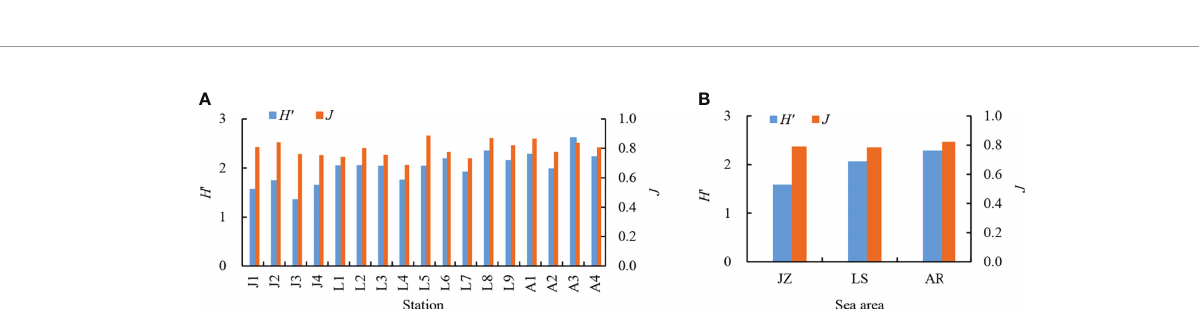
FIGURE 2 | Venn diagrams highlighting the degree of overlap of dinocyst taxa among the seventeen samples (A) and among the three sea areas (B) . JZ, the inner Jiaozhou Bay; LS, the Laoshan coast; AR, the Amphioxus Reserve area.